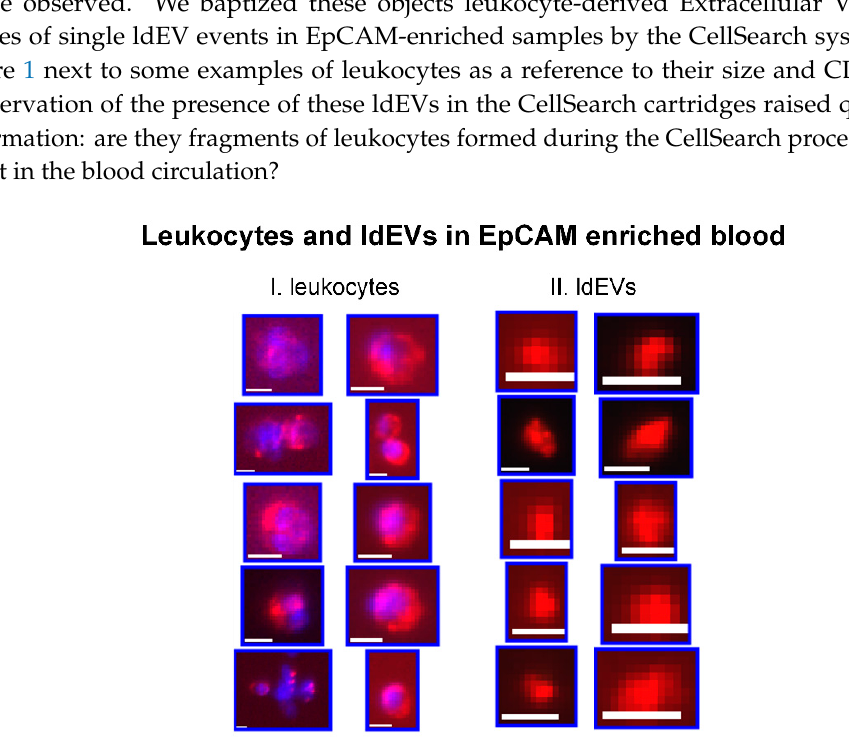
Figure 1. Thumbnails of I. leukocytes and II. Leukocyte-derived Extracellular Vesicles (ldEVs) detected in EpCAM-enriched blood samples. The red color represents CD45 and blue represents DAPI. Scale bars indicate 6.4 μ m.